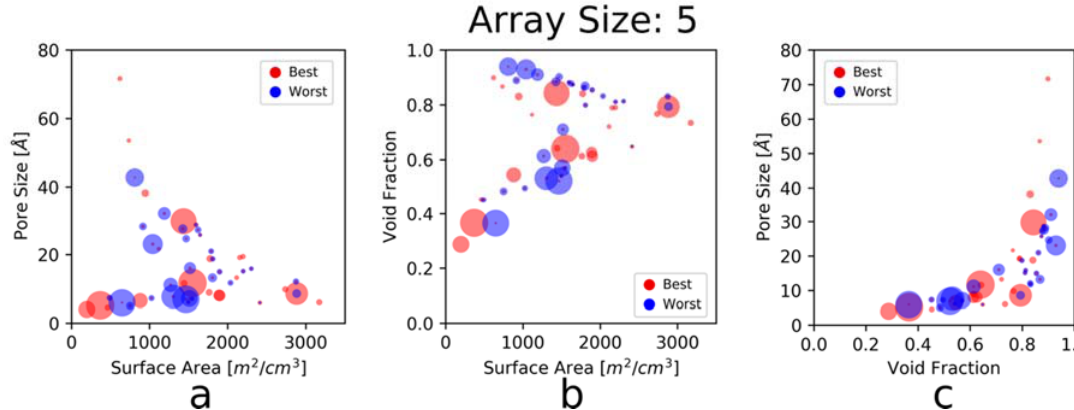
Figure 6. Physical property coupling (top/bottom 300 arrays), where (a) examines the relationship between pore size and surface area, (b) examines the relationship between void fraction and surface area, and (c) examines the relationship between pore size and void fraction. Dot color corresponds to elements of the best/worst arrays (red is for best arrays, blue for worst arrays) and dot size corresponds to the number of times the element is featured in the best/worst arrays (a larger dot corresponds to being present in more arrays). This is the same set of arrays used in Figure 5.